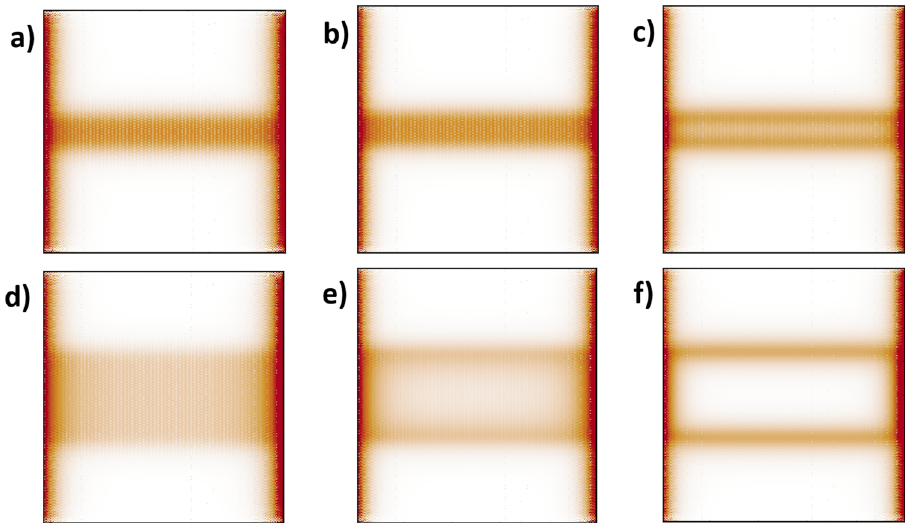
Fig. 6 LDOS pro fi les for different cases of λ SO and W j . We consider channel electrochemical potential E − U = 0 and disorder strength W = 0. a W j = 6.25 nm and λ SO = 0 eV. b W j = 6.25 nm and λ SO = 0.04 eV. c W j = 6.25 nm and λ SO = 0.1 eV. d W j = 20.8 nm and λ SO = 0 eV. e W j = 20.8 nm and λ SO = 0.04 eV. f W j = 20.8 nm and λ SO = 0.1